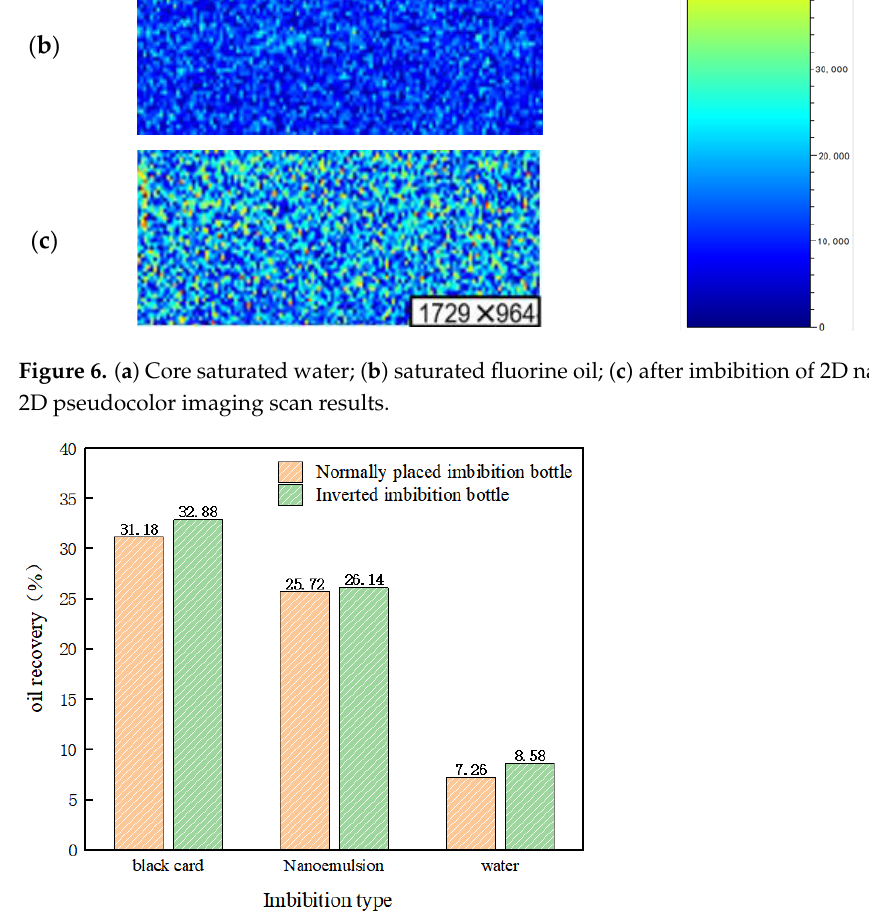
Figure 8. The relationship between the recovery degree of different imbibed fluids and imbibition time.